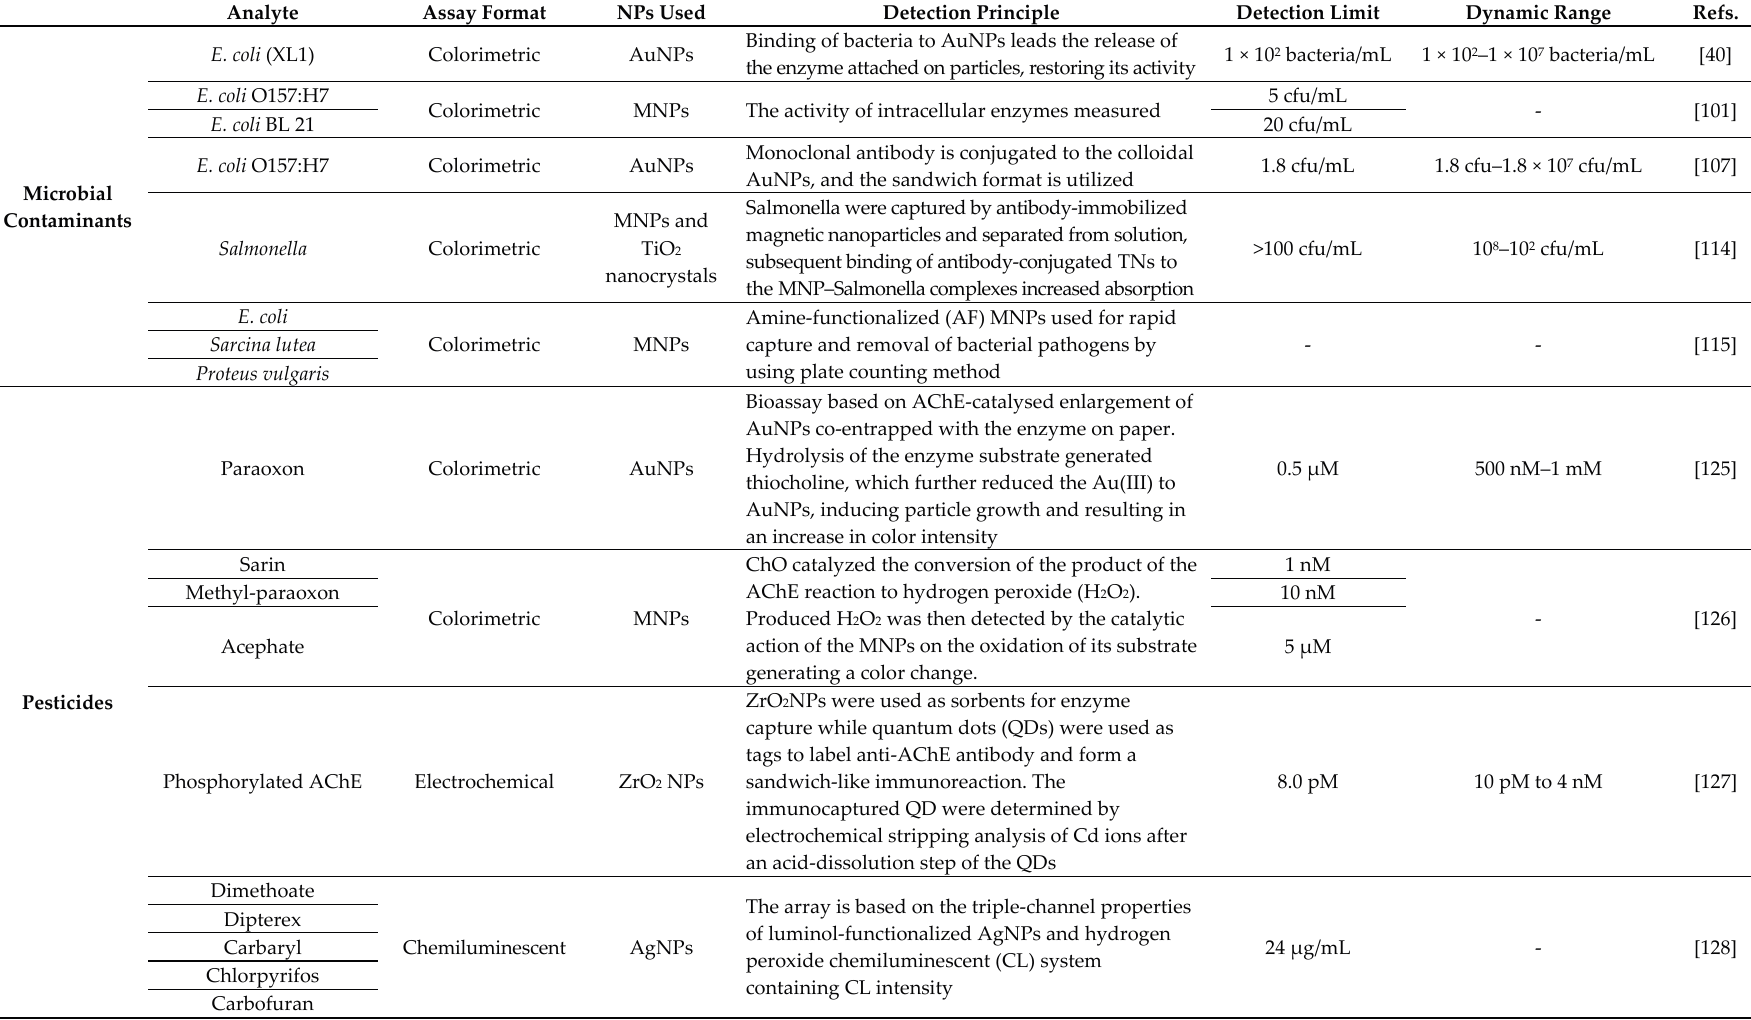
Table 1. Summary of analytical characteristics of reviewed studies on portable NP-based sensors for the detection of food